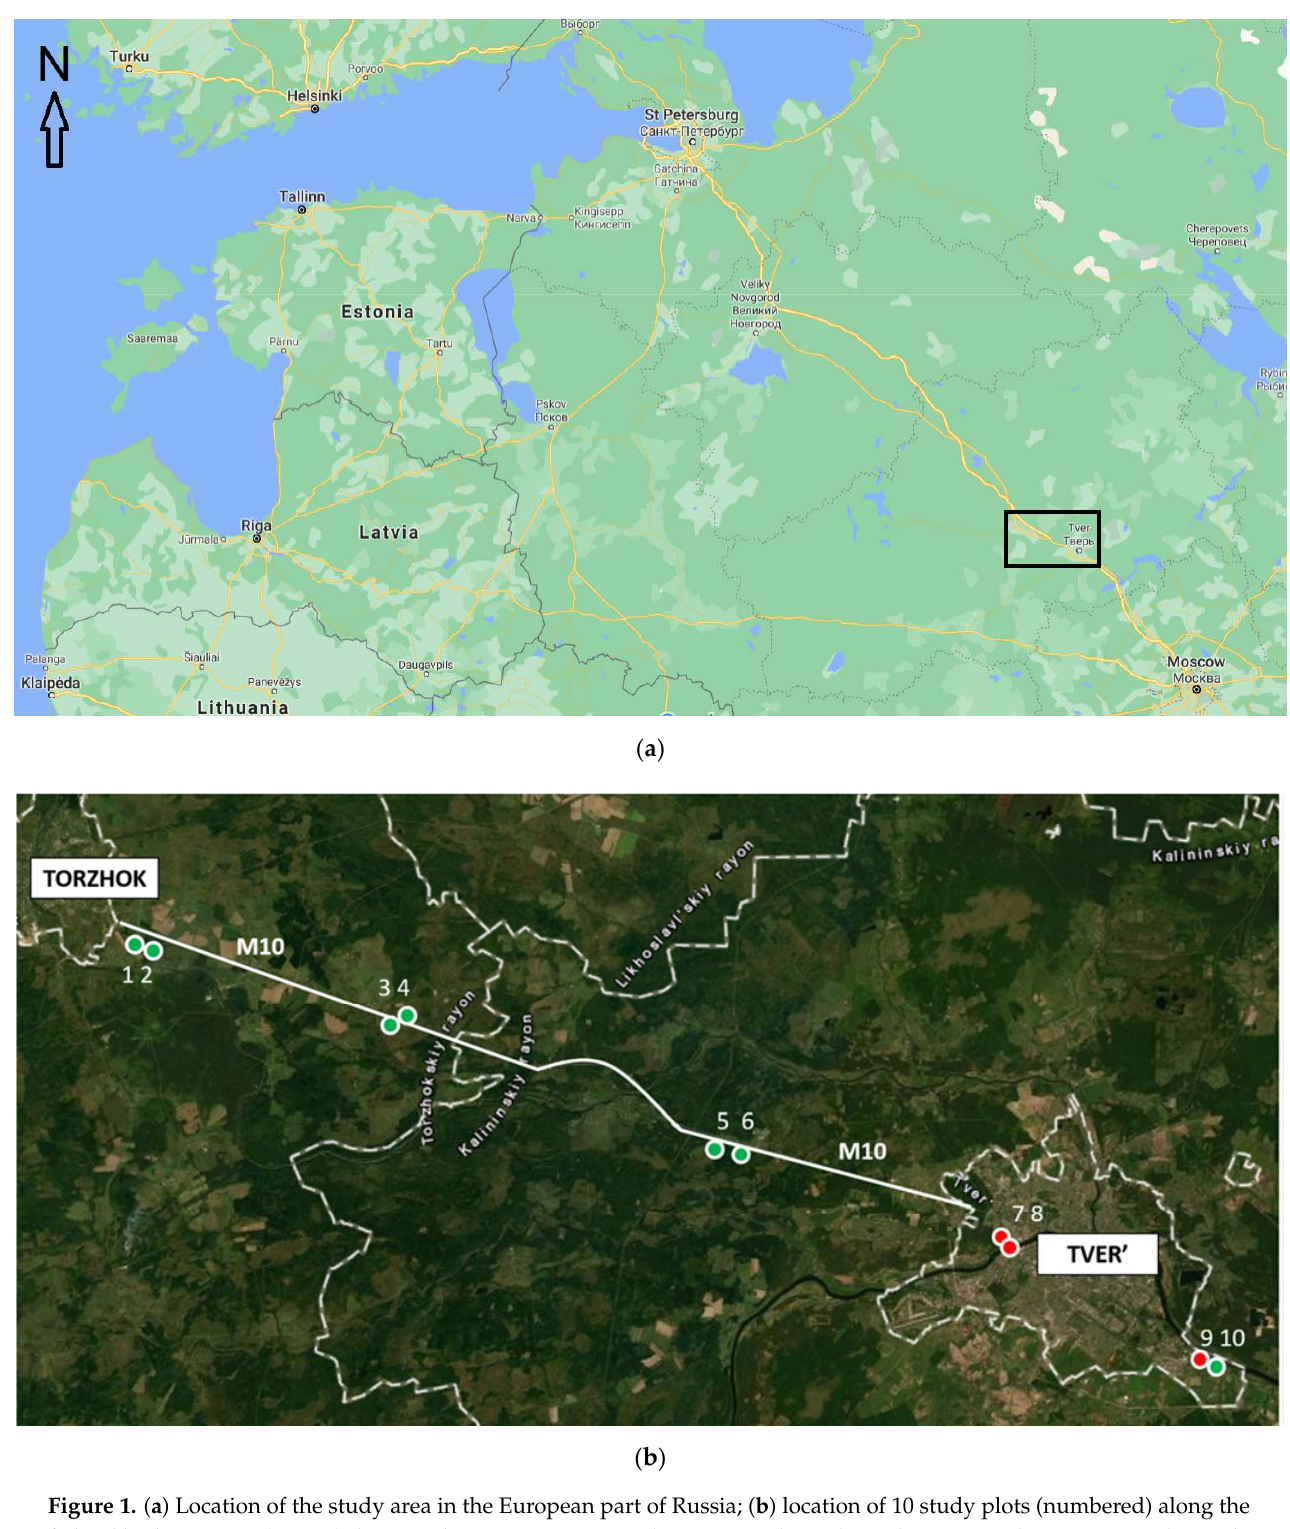
Figure 1. ( a ) Location of the study area in the European part of Russia; ( b ) location of 10 study plots (numbered) along the federal highway M10 (Russia) that runs between Moscow and Saint Petersburg through TVER’ and TORZHOK. The study plots where A. planipennis was recorded at least once on at least one tree are colored in red (# 7–9; see Table 1 for details). Maps are based on images from (C) Google, 2021.